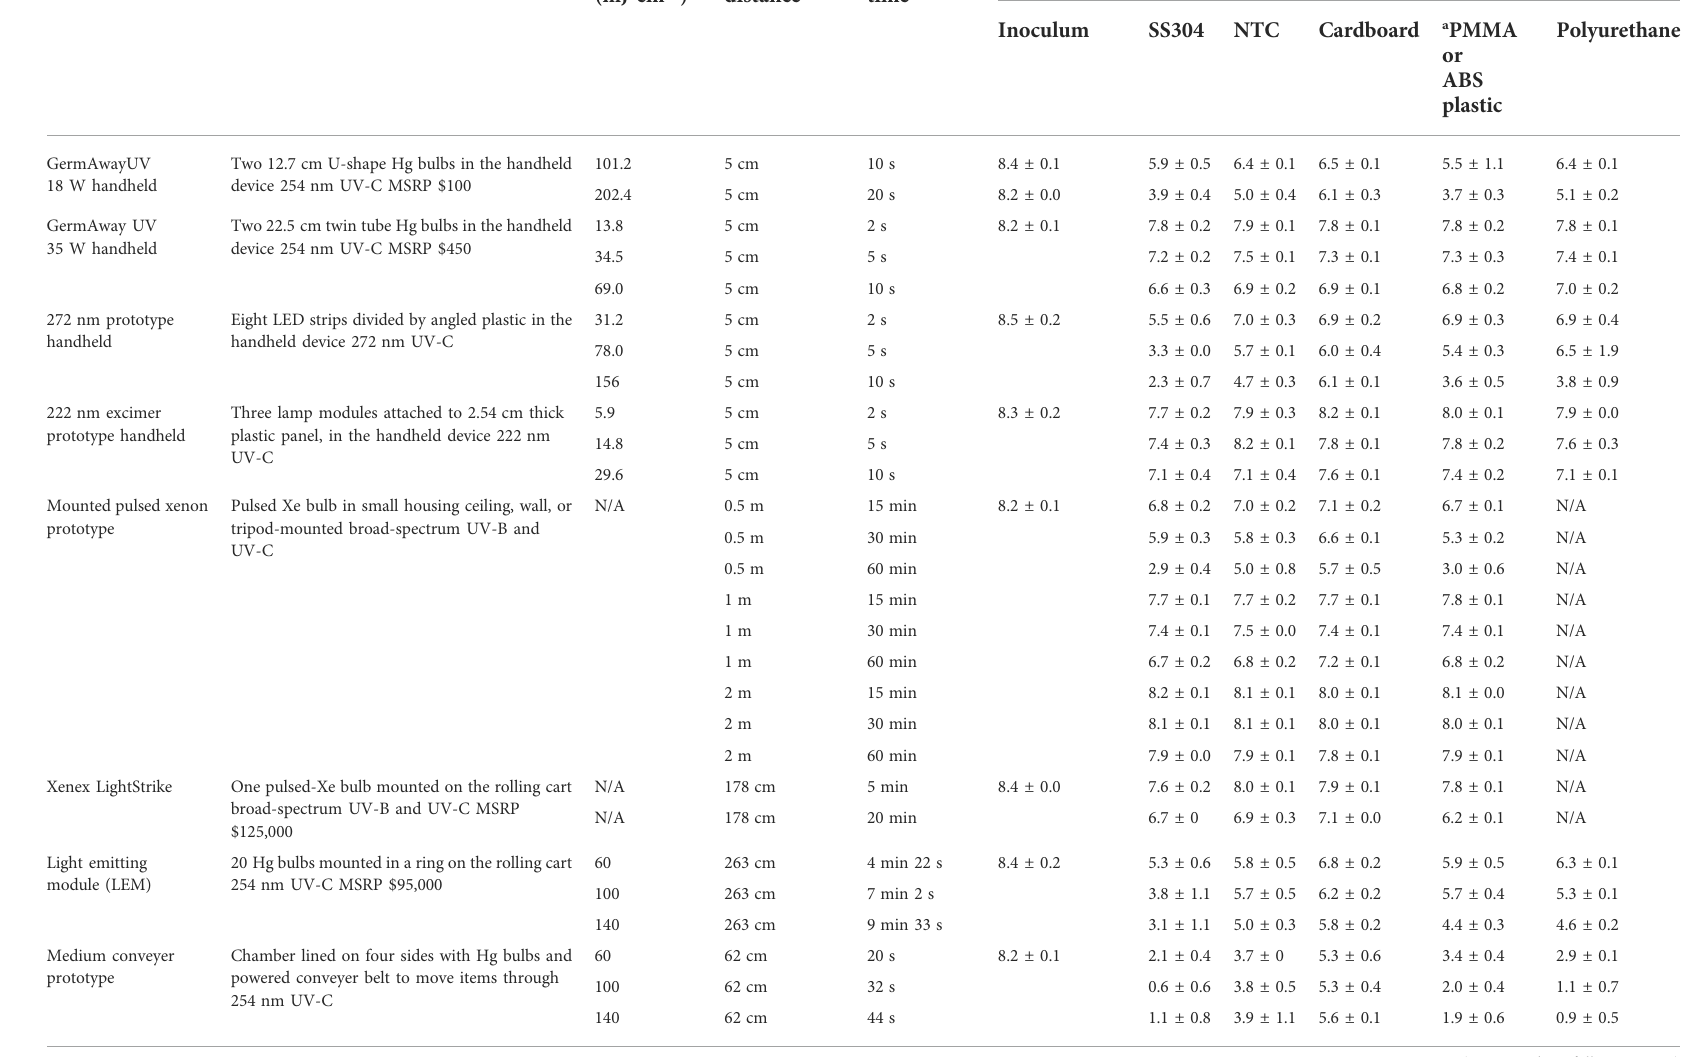
TABLE3Dosageandef fi cacyofhandheld,room,andchamber-typedevicesshowinglog 10 survivaldatabasedonthesteadystateemission,notpeakemission.White(lowdecontamination)=Fail < 2log 10 ; yellow(sanitation)=Fail ≥ 2log 10 , < 3log 10 ;lightblue(disinfection)=Pass ≥ 3log 10 ;anddarkblue(approachingvirussterilization)=Pass ≥ 6log 10 .N/A — dosagemeasurementshadnomeaningbecause of the broad-spectrum Xe source.